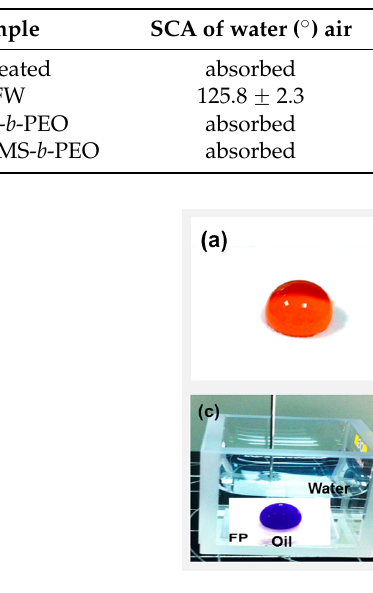
Figure 5. Young’s modulus ( a ), and tensile strength, and elongation percentage ( b ) of untreated, PFW, PDMS- b -PEO and PFW/PDMS- b -PEO -treated FP samples.